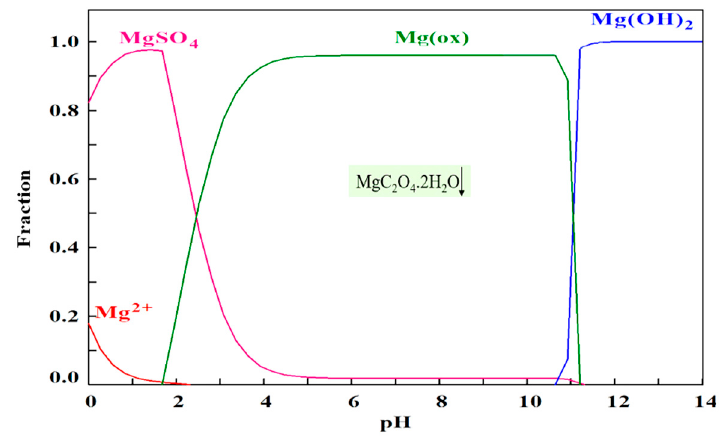
Figure 10. Species distribution diagrams of C 2 O 42 − /Mg-H 2 SO 4 systems containing 0.393 mol/L Mg 2+ ,